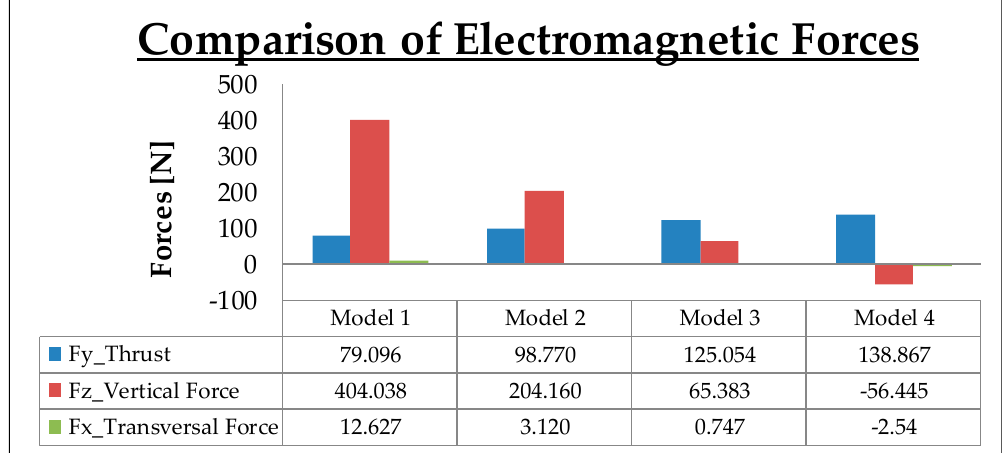
Figure 28. Comparison of the principal forces in each model.